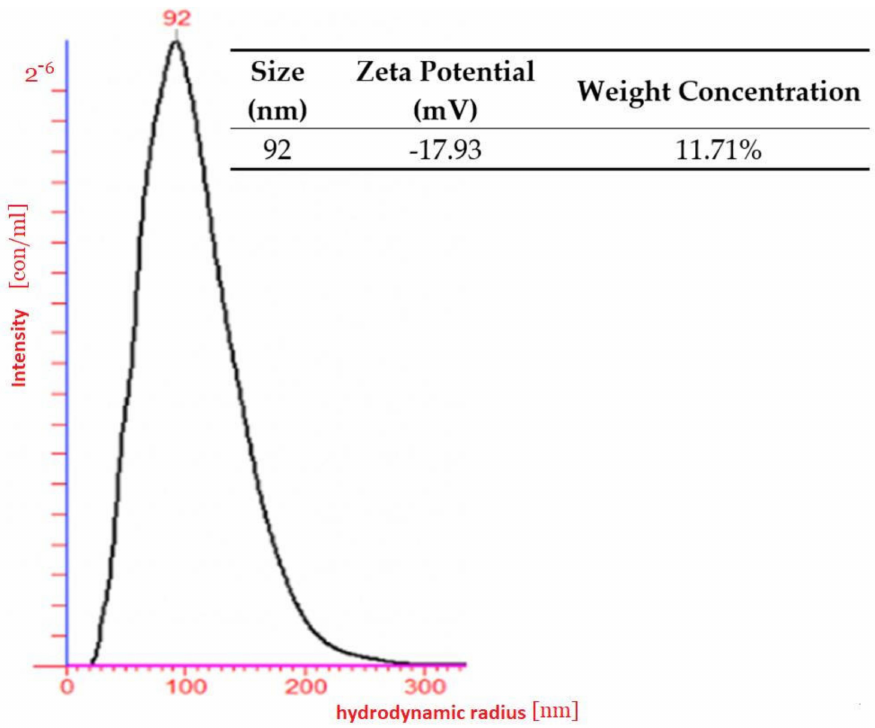
Figure 2. Hydrodynamic radius and size distribution of pNiPAM-HEMA-AA-oligoLA spheri- cal nanoparticles.